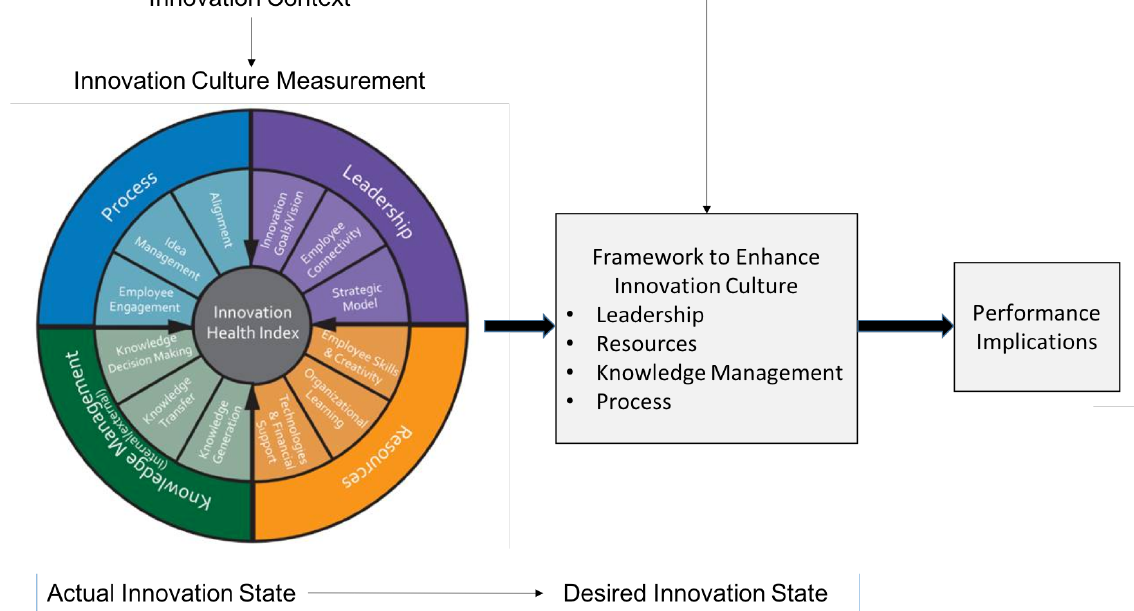
Fig. 3. Innovation Culture Measurement Model building on the Innovation Health Index (Dobni